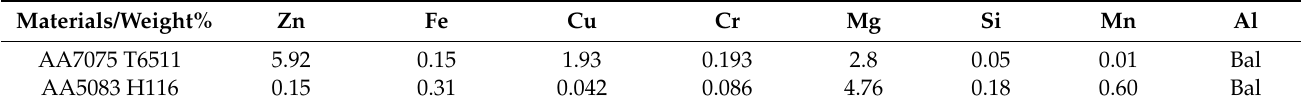
Table 1. Chemical composition of base metals.